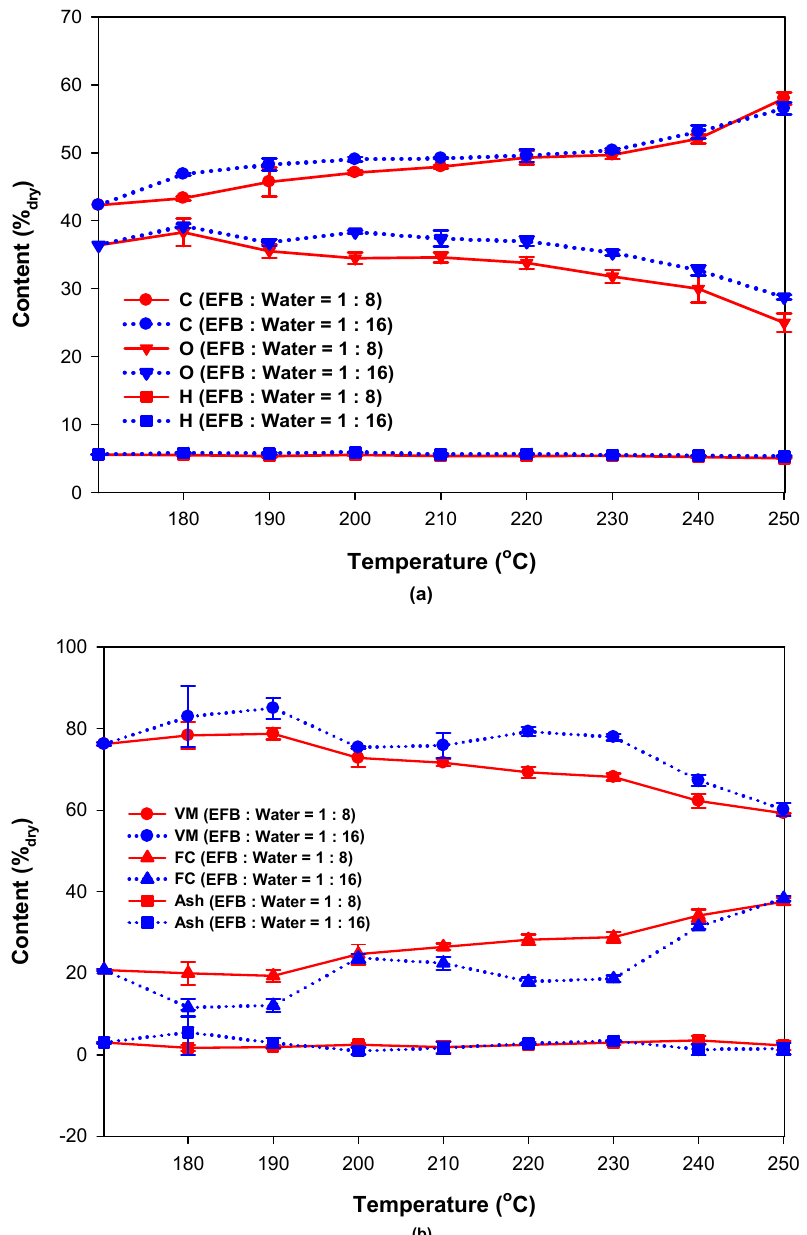
Figure 4. ( a ) Elemental and ( b ) proximate analysis of EFB according to reaction temperature and water content. Table 2. Elemental and proximate analysis of EFB according to reaction temperature (EFB:water = 1:8). Temperature